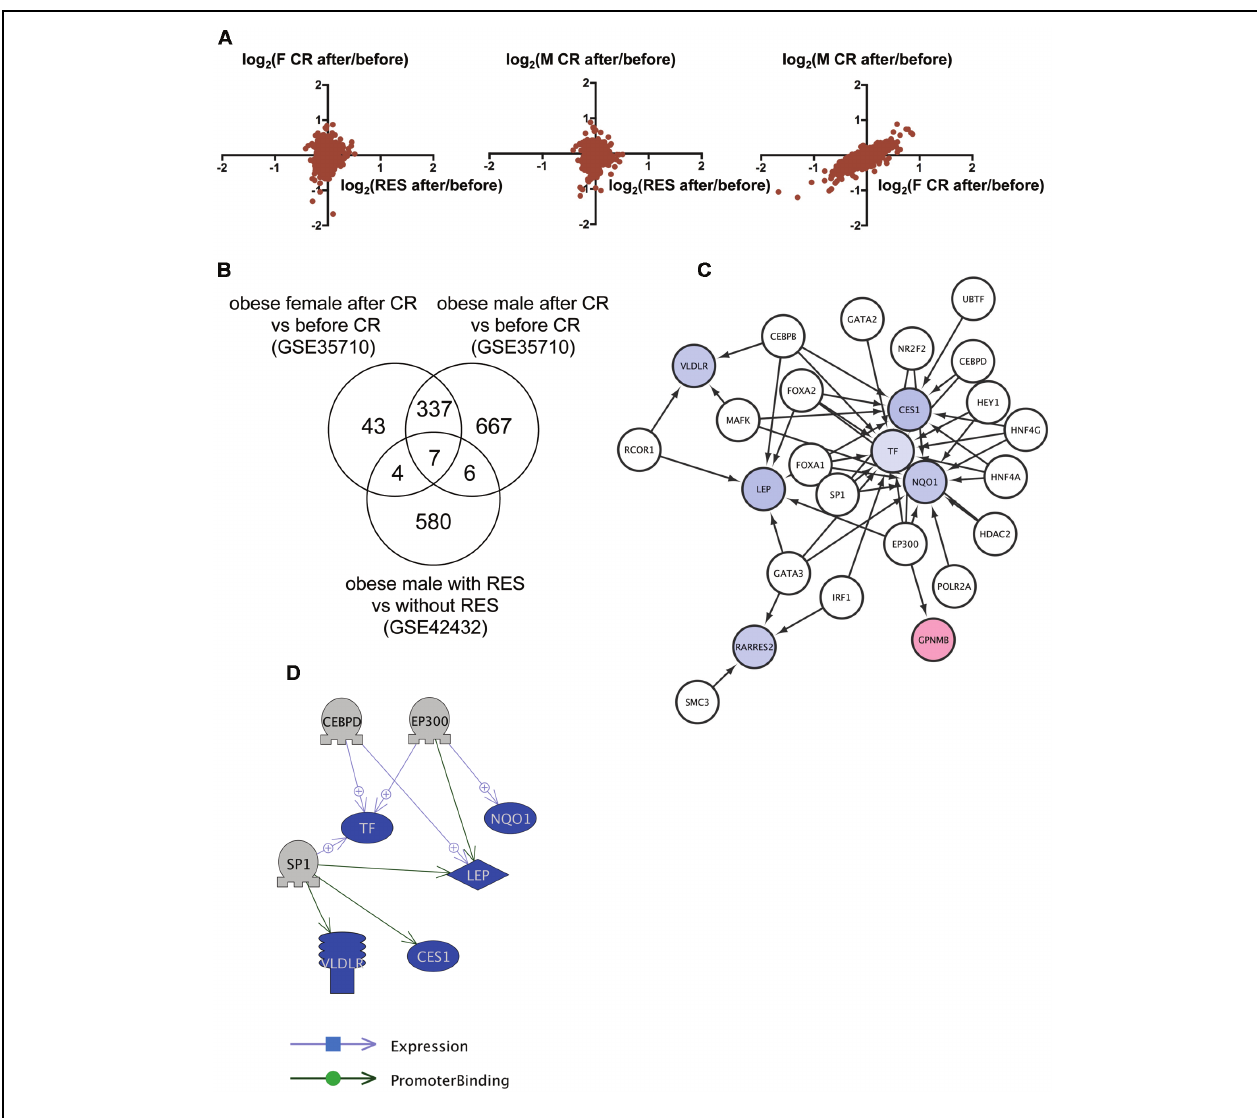
FIGURE 2 | Identification of the regulatory network of genes with changed expression levels common to RSV and CR in obese humans. (A) Correlation of gene expression changes by RSV in obese males and CR in obese females (left) or males (middle) and CR in obese females and males (right). (B) Venn diagram of the numbers of DEG by RSV in obese males, or CR in obese females or males. (C) A regulatory network identified by iRegulon for the seven common genes among RSV in obese males, and CR in obese females and males. Genes shown in blue and red indicate decreased and increased expression, respectively, by RSV or CR. (D) A regulatory network identified by Pathway Studio between three regulators and their five target genes. Genes shown in blue and red indicate decreased and increased expression, respectively, by RSV or CR.